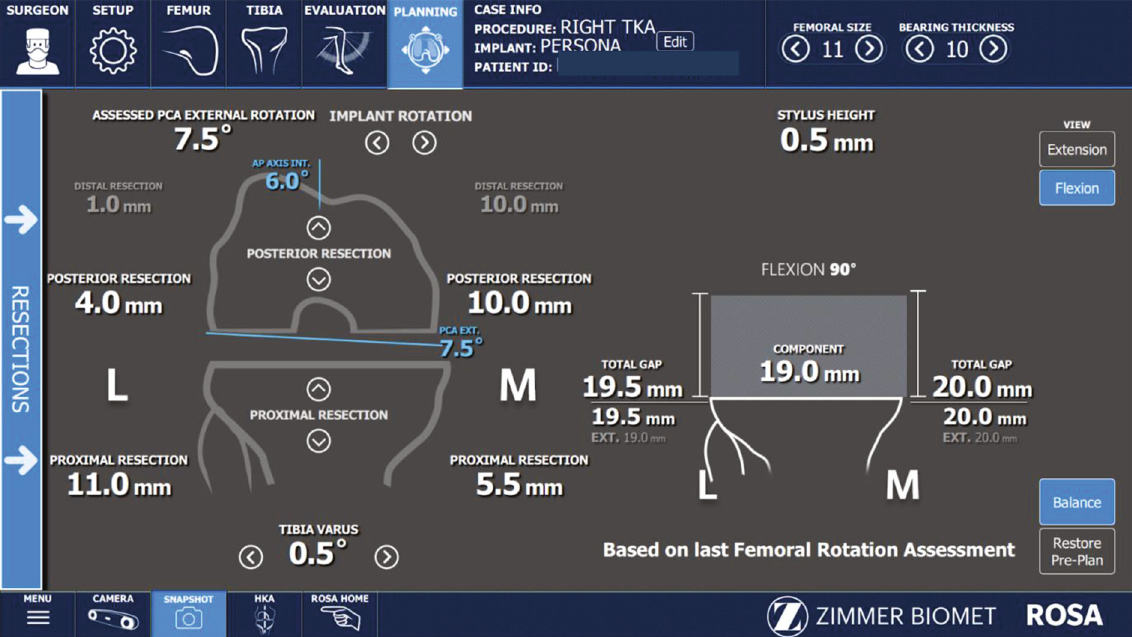
Figure 6: An intraoperative generated plan of Case 2 demonstrating planned femoral and tibial